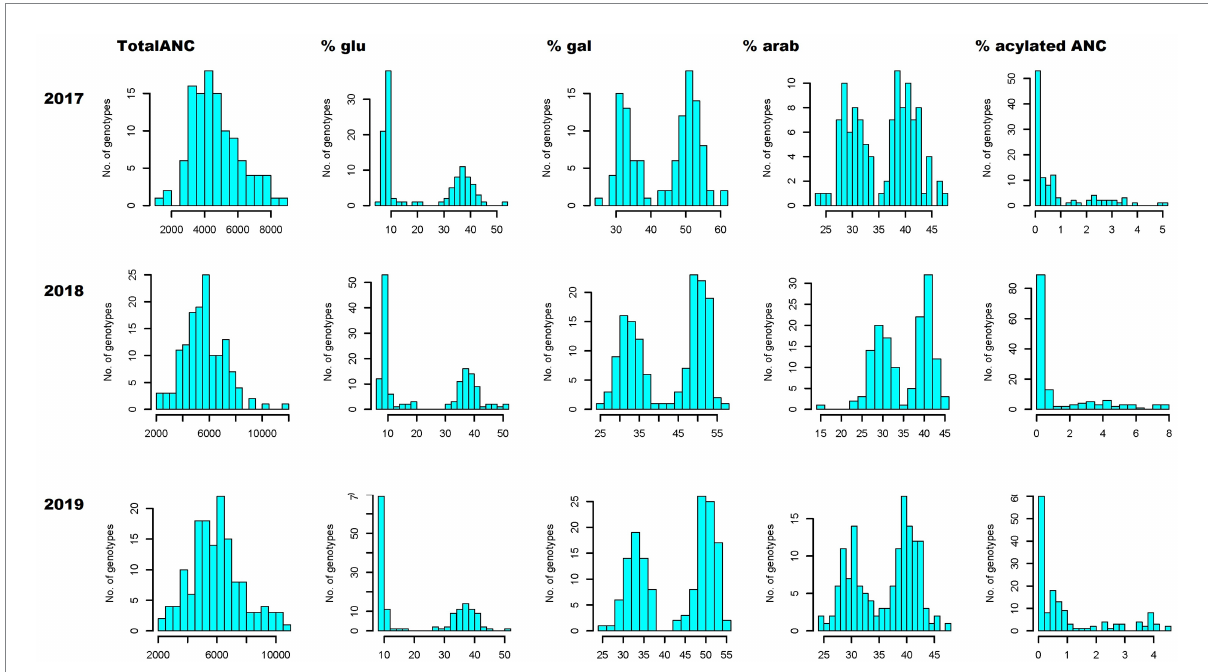
FIGURE 1 Anthocyanin phenotypic variation. Phenotypic distribution of totalANC (ug/g, fresh weight), contribution (%) of anthocyanins conjugated with different sugar moieties (glucoside, galactoside and arabinoside) and acylated ANC relative to the totalANC, over 3 years (2017–2019). glu, -3-glucoside; gal, -3-galactoside; arab, -3-arabinoside; TotalANC, total